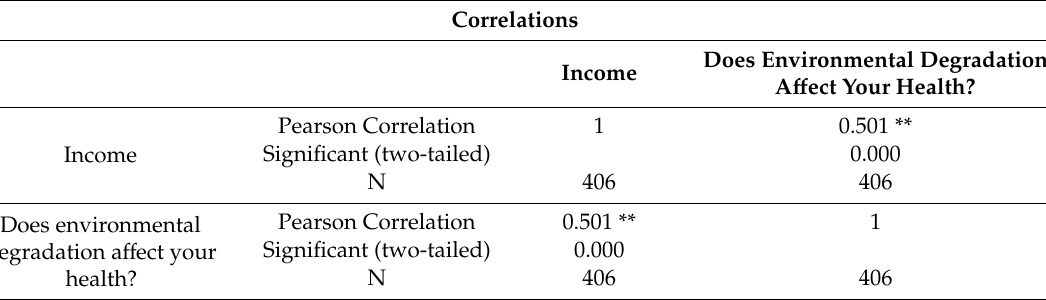
Table A2. Income correlations results.